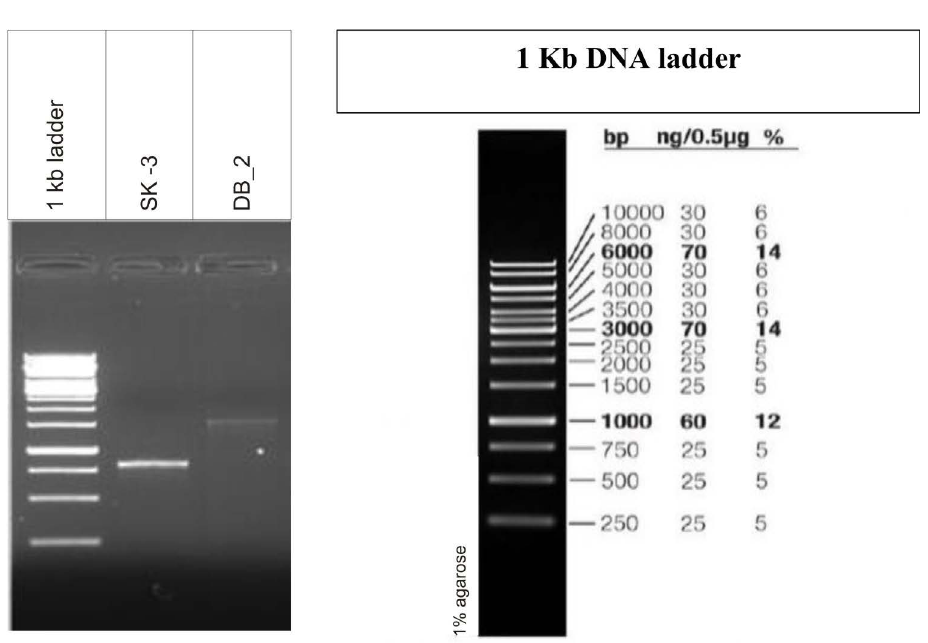
Fig. 3. Molecular identification of Lactobacillus strains by 16S rRNA